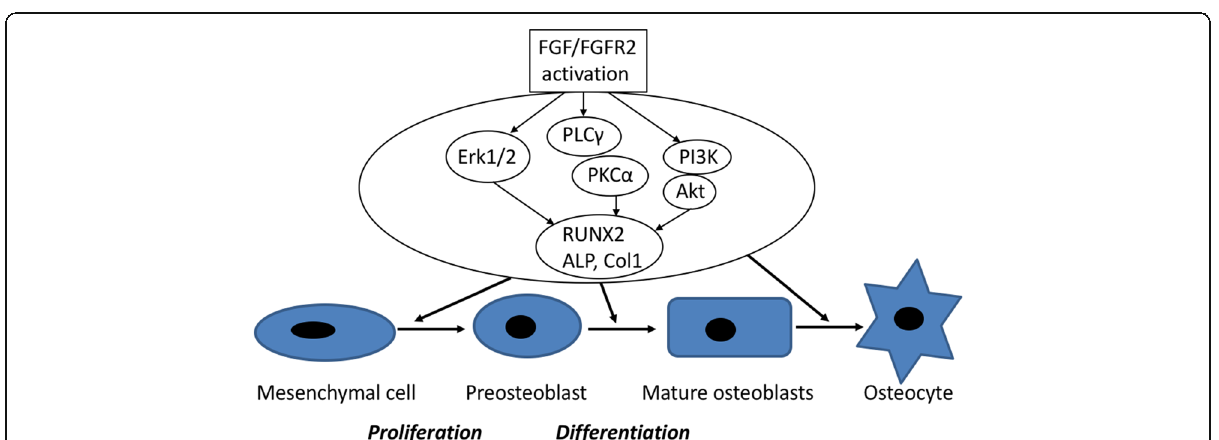
Fig. 3 Schematic representation of FGF-FGFR signaling pathways and mechanisms in osteogenesis. The regulation of osteogenesis by FGF and FGFR. FGF/FGFR signaling is an important regulator of osteoblastogenesis, and that control osteoblast replication and differentiation. Activation of FGF and FGFR triggers the activation of ERK1/2 MAPK, PLC γ /PKC, and Akt activity which upregulate osteoblast gene expression and osteogenesis. Abbreviations: FGF, fibroblast growth factor; FGFR, fibroblast growth factor